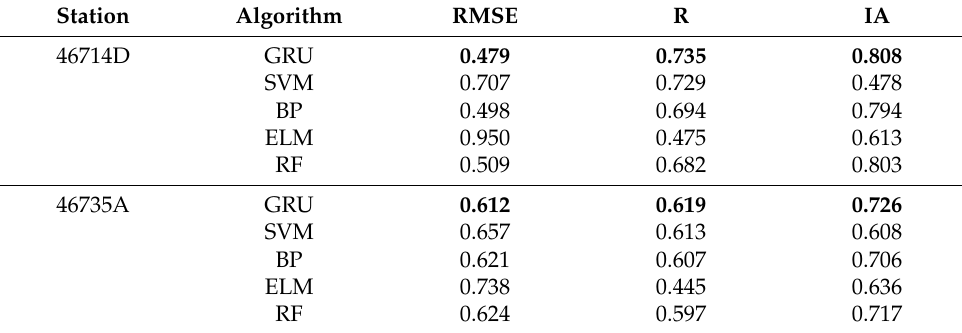
Table 6. Error indices of predicted SWH with lead times of 24 h.